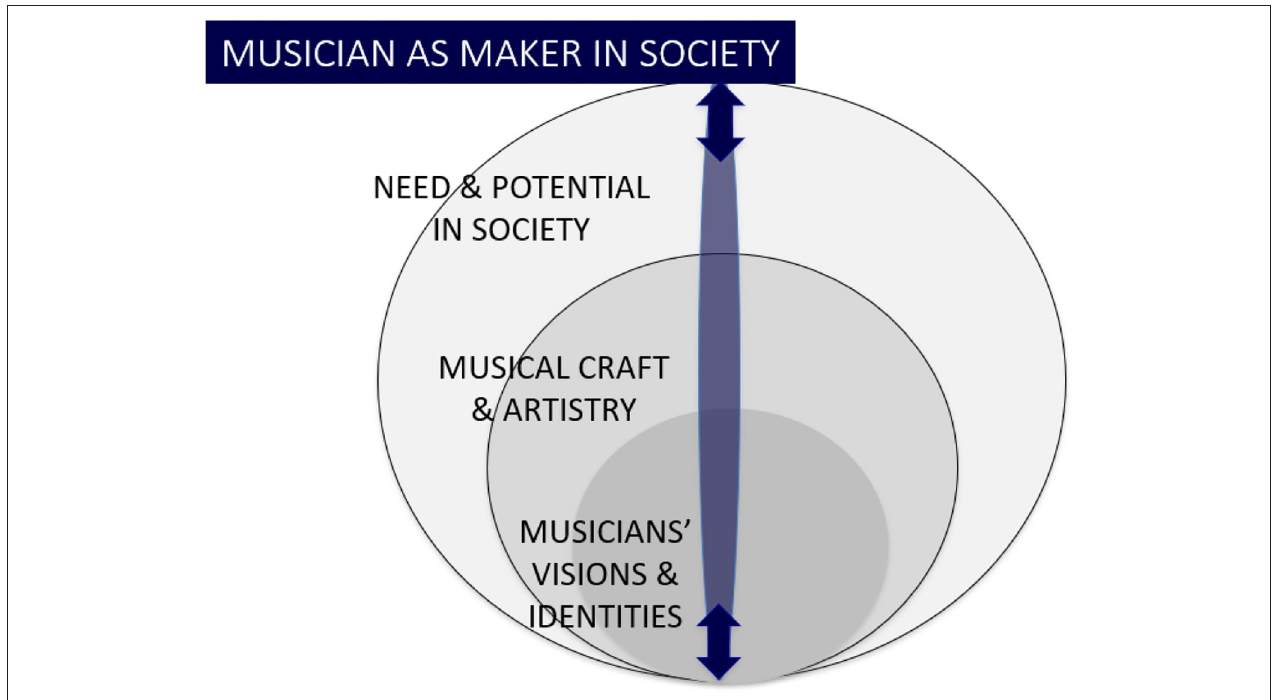
FIGURE 3 | The musician as maker in